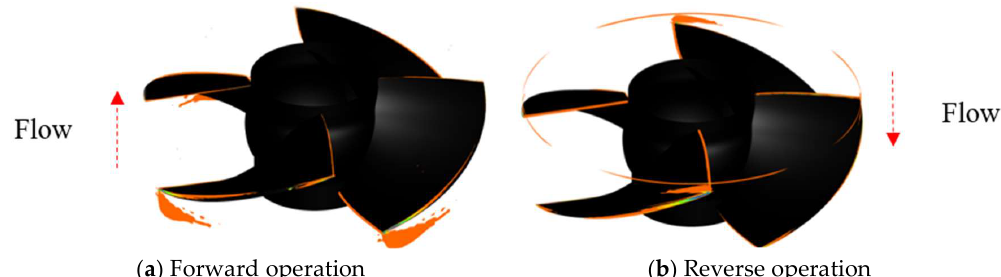
Figure 20. 1.0 Q d impeller internal vorticity distribution diagram.